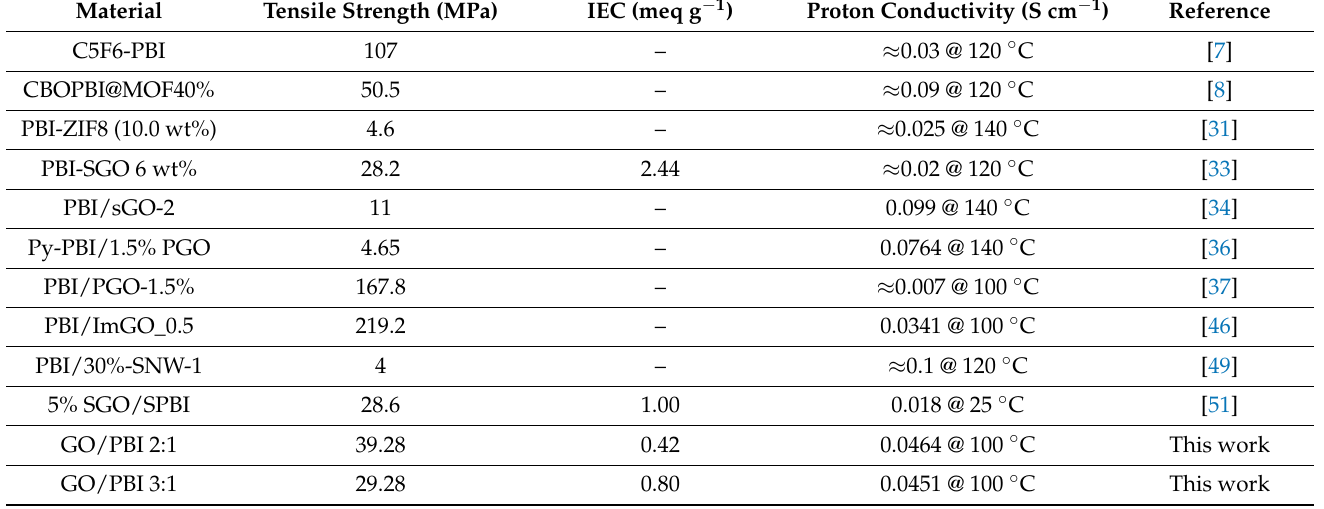
Table 4. Comparison of the properties of GO/PBI 2:1 and GO/PBI 3:1 with other state-of-the-art GO- and PBI-related materials reported in the